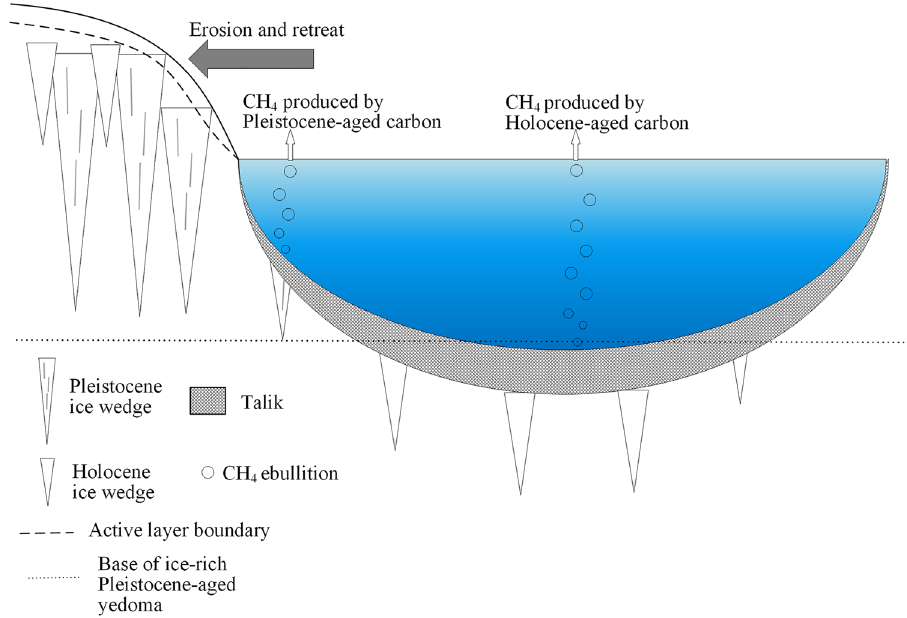
Fig. 1 Schematic showing the thaw-lake CH production by 4 organic carbon of different ages. The supply of H to CH 4 production by Late Pleistocene carbon occurs along thermo- karst erosion margins, and the radiocarbon age of CH tend 4 to be younger (e.g., Holocene- aged) toward the lake center. The figure is modified from Brosius et al.